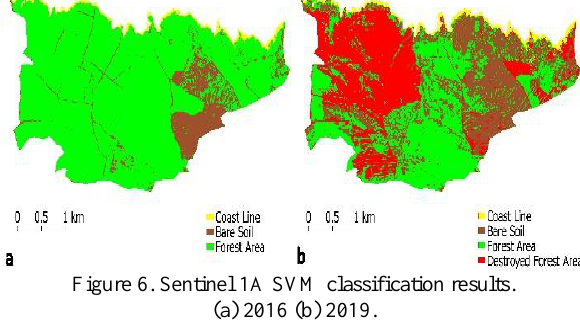
Figure 6. Sentinel 1A SVM classification results. (a) 2016 (b)